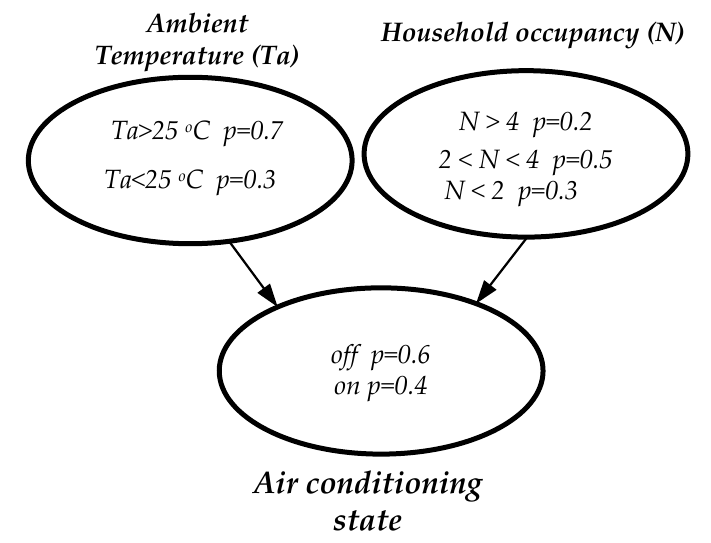
Figure 3. Example of Bayesian